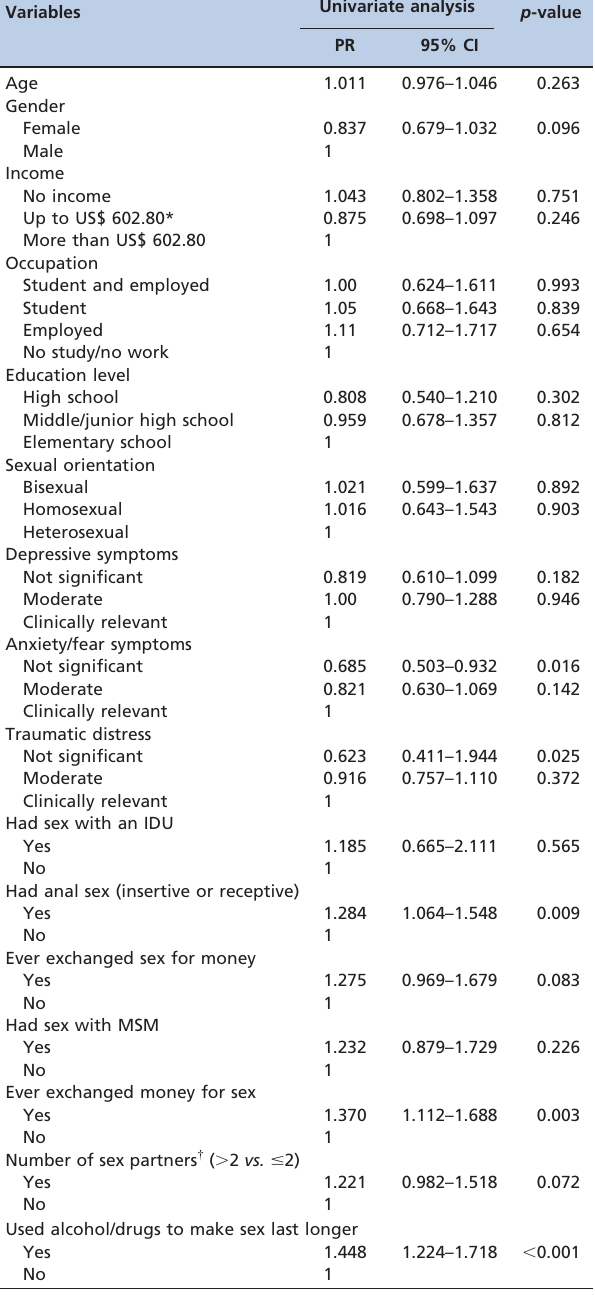
Table 2 - Univariate analysis of candidate variables for inclusion in the multivariate